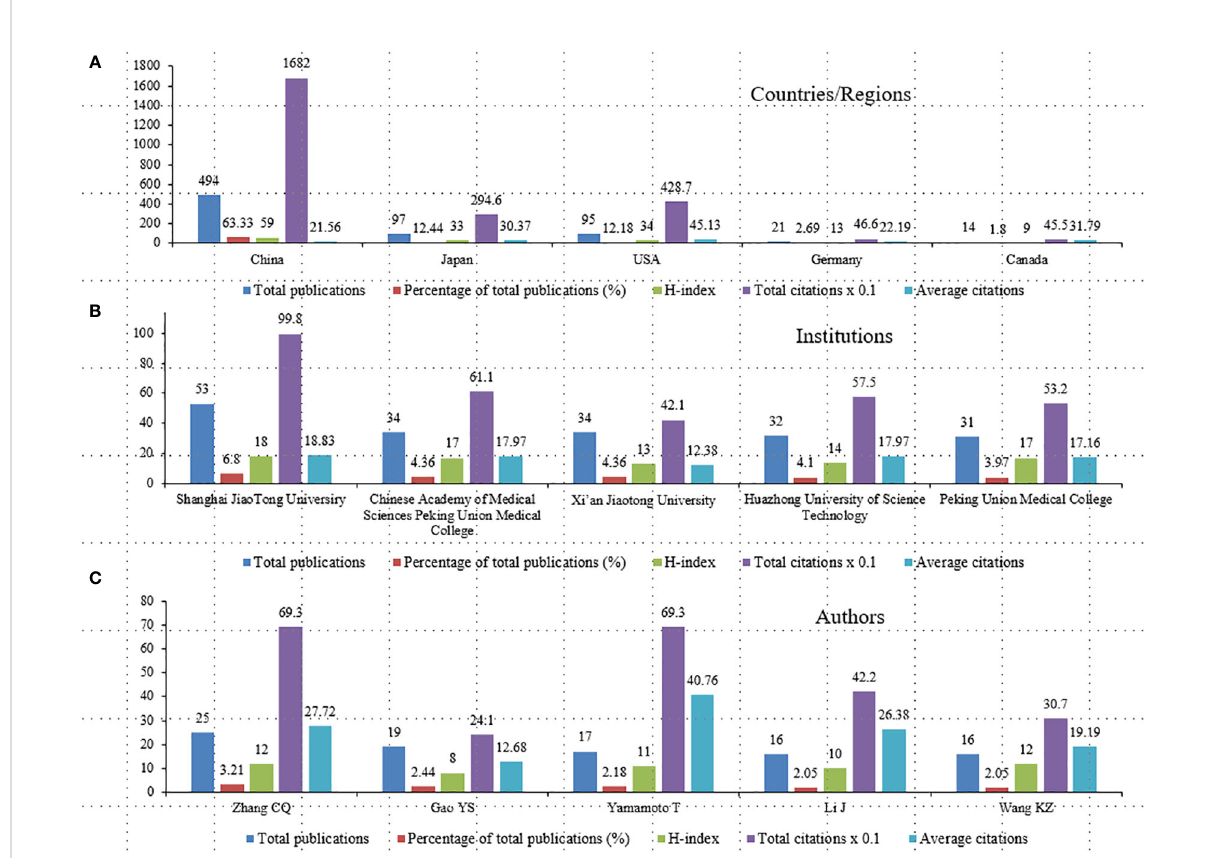
FIGURE 4 The Top 5 productive countries/regions, institutions, and authors on SONFH from 1992 to 2021. (A) Total publications, percentage of total publications (%), H-index, total citations, and average citations per item of the top 5 countries/regions by contributions; (B) Total publications, percentage of total publications (%), H-index, total citations, and average citations per item of the top 5 institutions by contributions; (C) Total publications, percentage of total publications (%), H-index, total citations, and average citations per item of the top 5 authors by